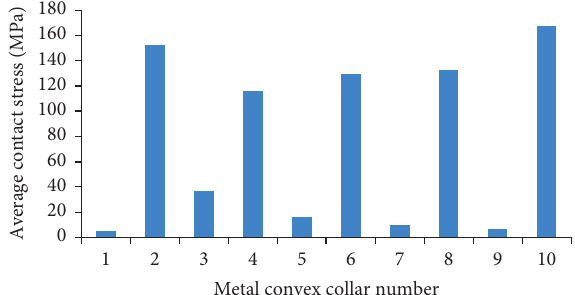
Figure 18: Average contact stress on each metal collar.